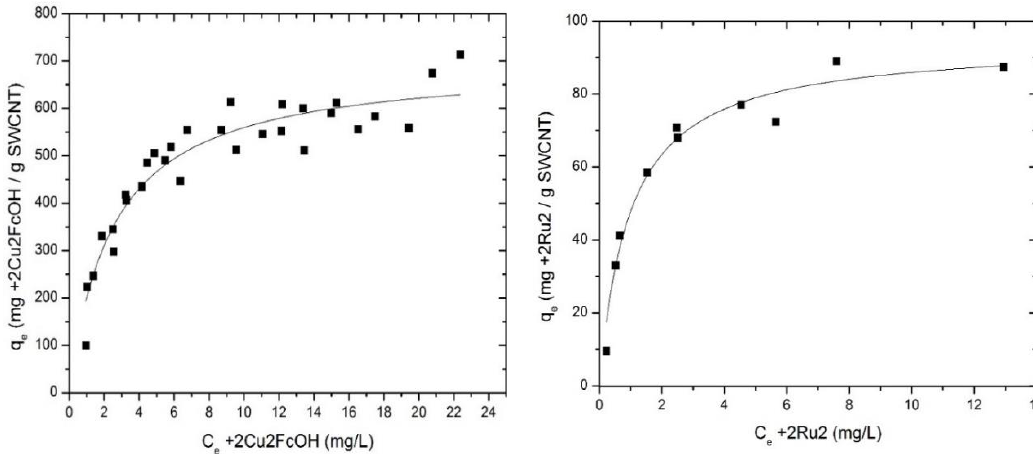
Figure 6. Adsorption isotherms of +2Cu2FcOH ( left ) and +2Ru2 ( right ) on HiPco SWCNTs and fit to a Langmuir model. The molecular model of +2Cu2FcOH is shown in the inset ( left ).